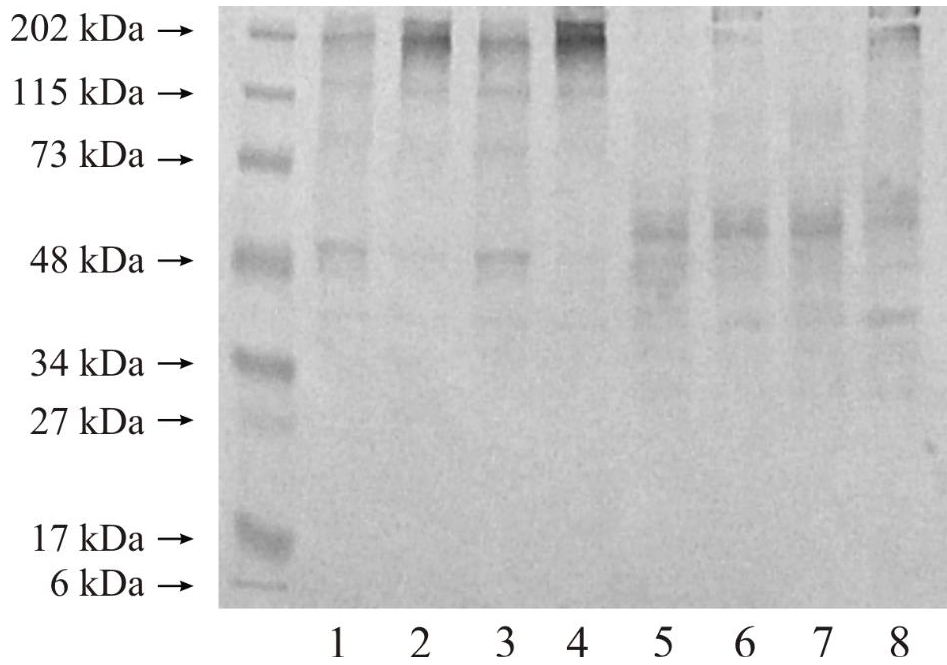
Figure 5. Western immunoblot of MMP-10 in respective control tissue and G2 grade and G3 grade human kidney tumor. Twenty micrograms of protein were applied on the gel. Separation in non- reducing conditions: Lane 1—control kidney for G2 grade tumor, 2—G2 grade of kidney tumor, 3—control kidney for G3 grade tumor, 4—G3 grade of kidney tumor. Separation in reducing conditions: Lane 5—control kidney for G2 grade tumor, 6—G2 grade of kidney tumor, 7—control kidney for G3 grade tumor, 8—G3 grade of kidney tumor.